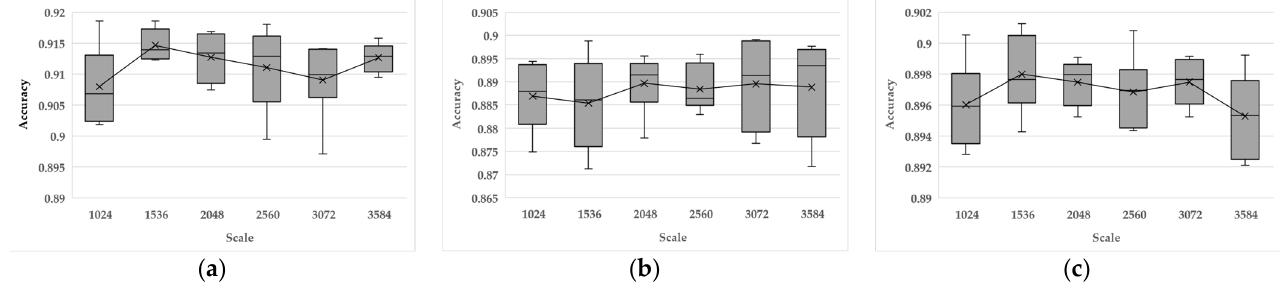
Figure 11. The accuracy performance on RWC ( a ), JMD ( b ), and Mir1k ( c ) with the different scales of spectrograms.